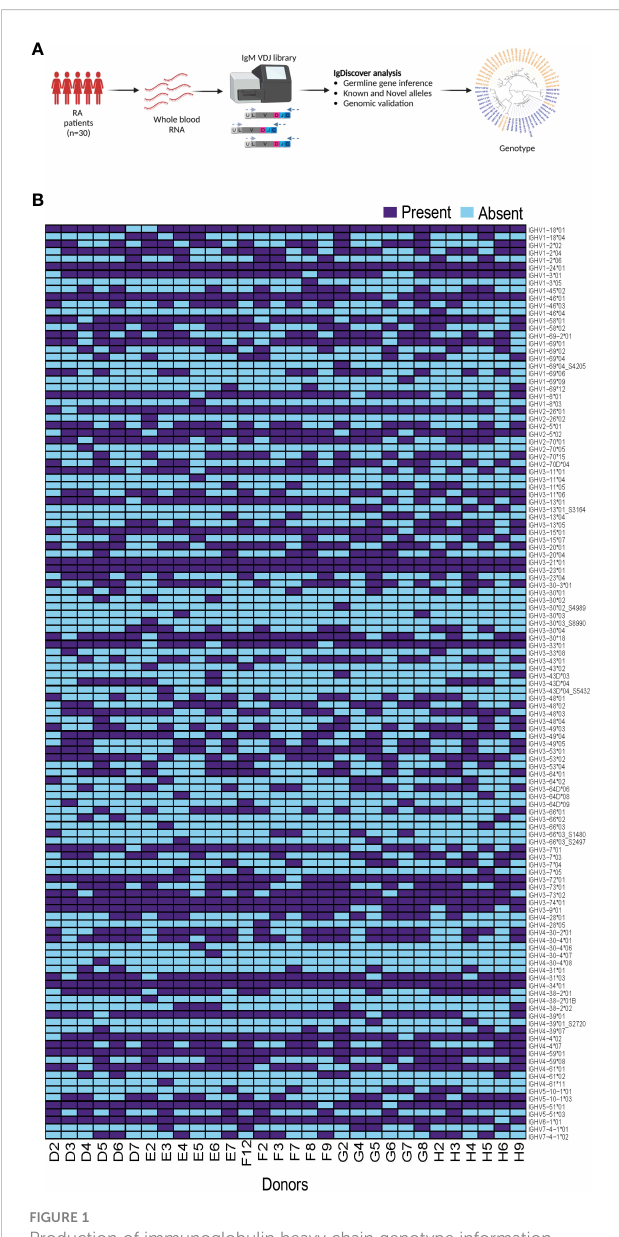
FIGURE 1 Production of immunoglobulin heavy chain genotype information from 30 individuals. (A) The fl owchart shows the process from whole blood RNA isolation, IgM library preparation and subsequent IgDiscover analysis. (B) Heatmap showing expressed IGHV alleles for all 30